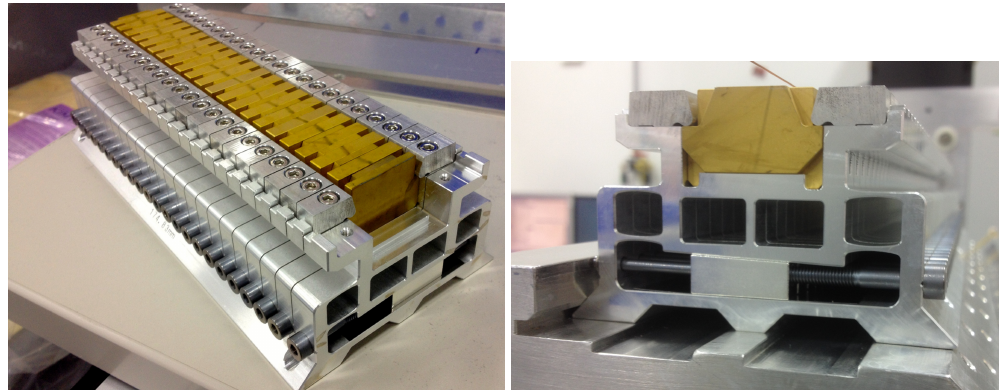
Figure 4. Magnet block keeper made of extruded aluminum. The height of the magnets can be adjusted by the wedge shown in the image to the